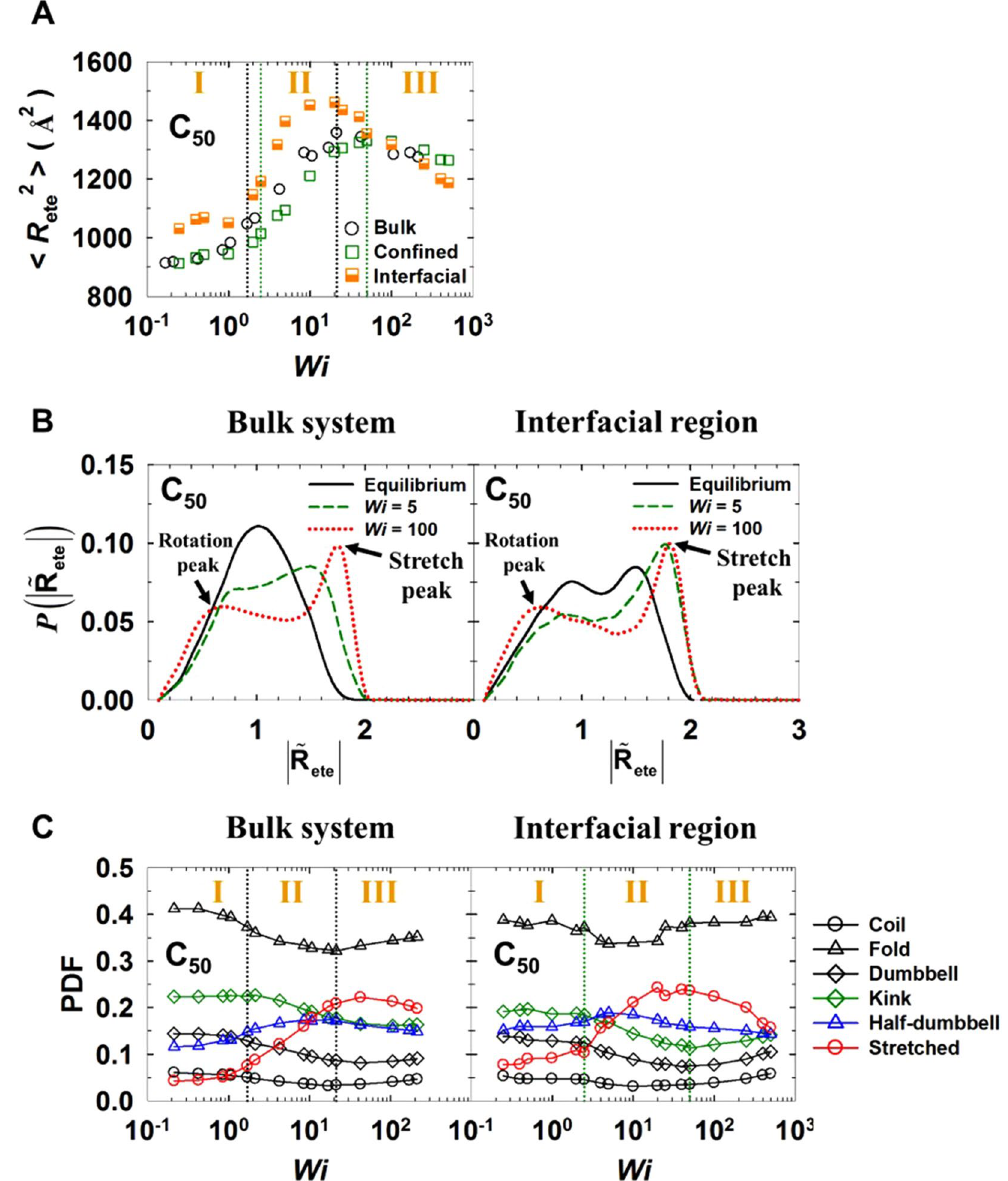
Figure 2. Comparison of the mesoscopic and macroscopic structural properties of the bulk and confined systems. ( A ) Mean-square chain end-to-end distance 〈 R ete2 〉 as a function of Wi for the bulk and confined C 50 PE melt systems. “Interfacial” represents the corresponding result for only the interfacial chains in the confined system. The interfacial regions of both top and bottom walls for the confined systems are found to produce practically identical results (within the statistical uncertainties) for all the microscopic and macroscopic structural and dynamical properties, e.g., 〈 Rete2 〉 and its PDF, molecular conformations via the Brightness method, interfacial residence time, and so forth. The error bars are smaller than the size of the symbols unless otherwise specified. Comparison of the bulk system and the interfacial region in the confined system for the C 50 ∼ PE melt for ( B ) the probability distribution function, P R ( ) ete , of the chain end-to-end distance (normalized by ∼ the equilibrium value ( = R R R / ete ete ete eq ) for each system), and ( C ) the probability distribution function (PDF) of the six representative mesoscale chain configurations (Coil, Fold, Kink, Dumbbell, Half-dumbbell, and Stretched) as a function of Wi computed by the Brightness